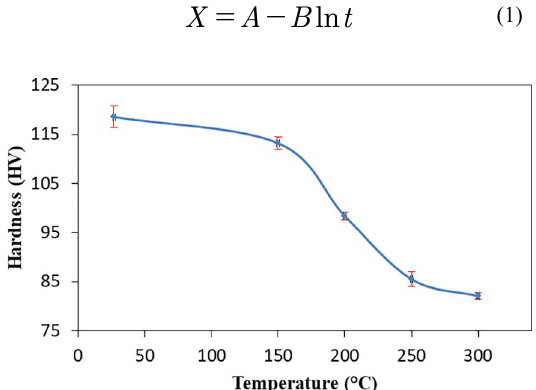
Figure 7. Softening behavior of cold - rolled (45%) samples annealed for 4 hours at different temperatures